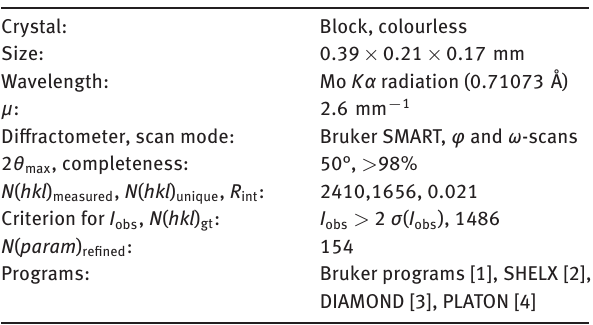
Table 1: Data collection and handling.